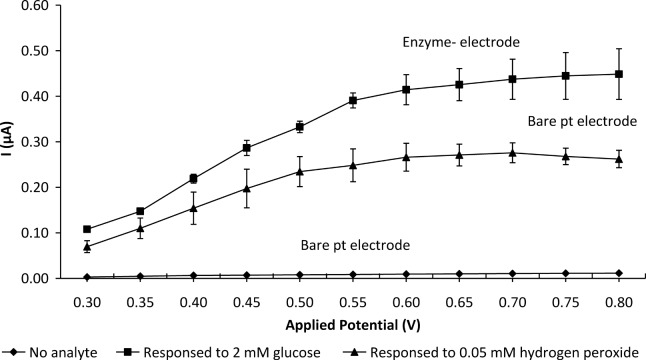
Effect of applied potential on the steady-state response with a bare platinum electrode in sensing 0.05 mM H2O2 and GOD-CHIT/PT in detecting 2 mM glucose.Phosphate buffer was used as the medium in both cases. Mean ± SD, n = 4.